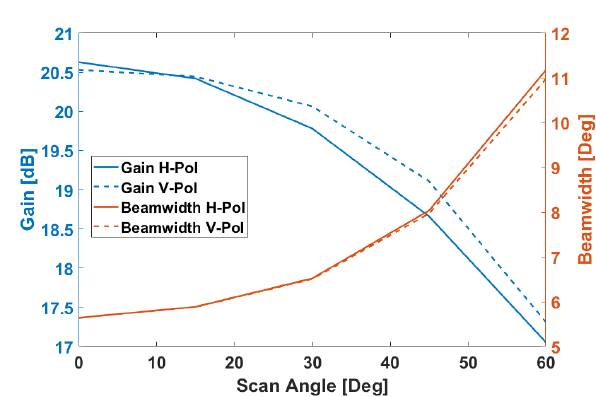
FIGURE 7: Variation in gain and beamwidth of the 2X20 array with scan angle